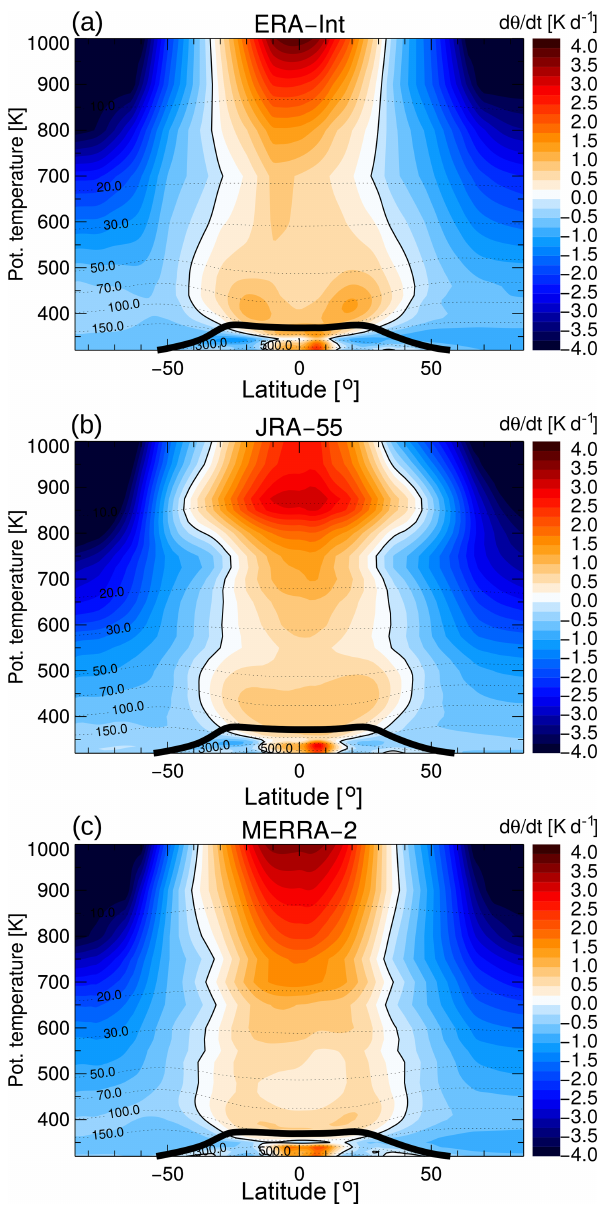
Figure 6. Norm of the climatological (1989–2015) age spectra for ERA-Interim (a) , JRA-55 (b) and MERRA-2 (c) . Blue contours show the climatological tail decay timescale (in years), the thin black dashed lines show the pressure levels in hPa, and the thick black line is the (lapse rate)